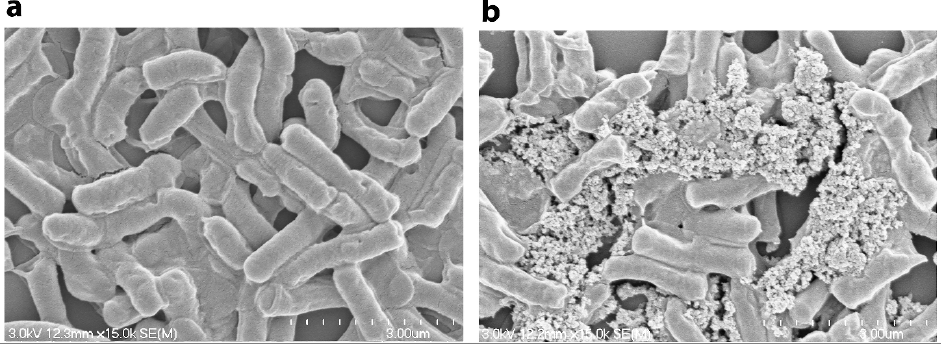
Figure 6. SEM image of the produced Bacillus subtilis natto cells ( a ) untreated and ( b ) decorated with L -lysine-IONs.